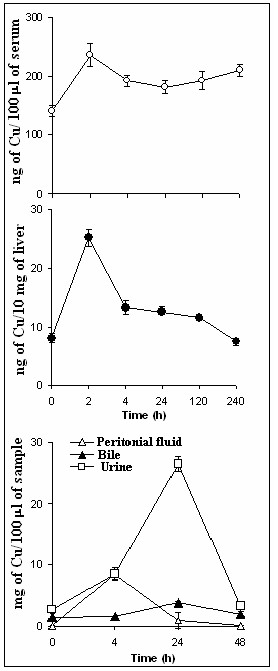
Copper levels in serum, liver and in peritoneal fluid, bile and urine of normal and EAC/Dox bearing mice following CuNG treatment. Results presented as mean ± S.D. of 6 independent experiments, each involving 3 animals in each experimental group.